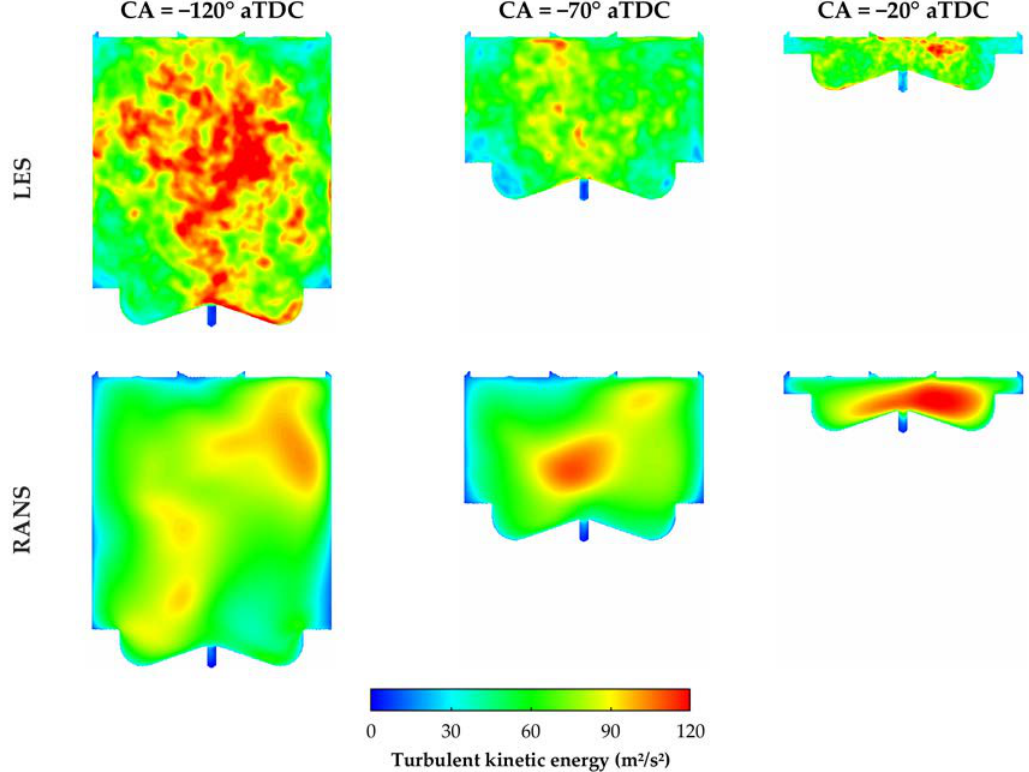
Figure 8. In-cylinder turbulent kinetic energy of RANS and LES at three different positions during compression.